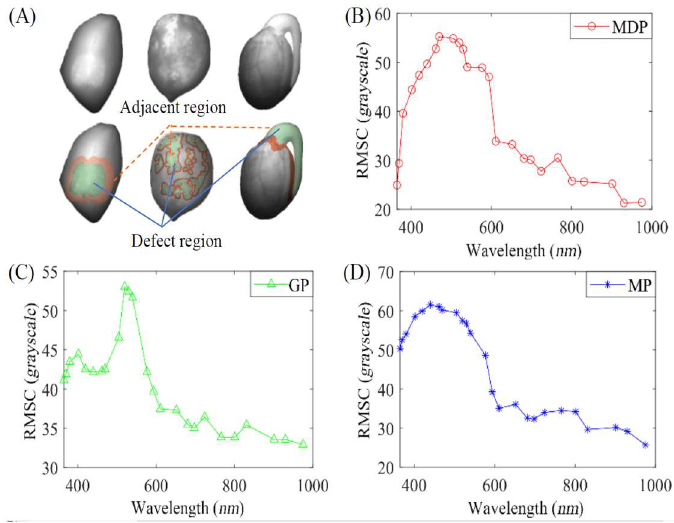
Figure 2. Calculation procedure and results of RMSC: ( A ) schematic diagram of peanut defects segmentation and their neighborhoods (The area indicated by the yellow dashed line is adjacent region, and the area indicated by the blue solid line is defect region); ( B – D ) calculated results of root-mean-square contrast at defect wavelengths.